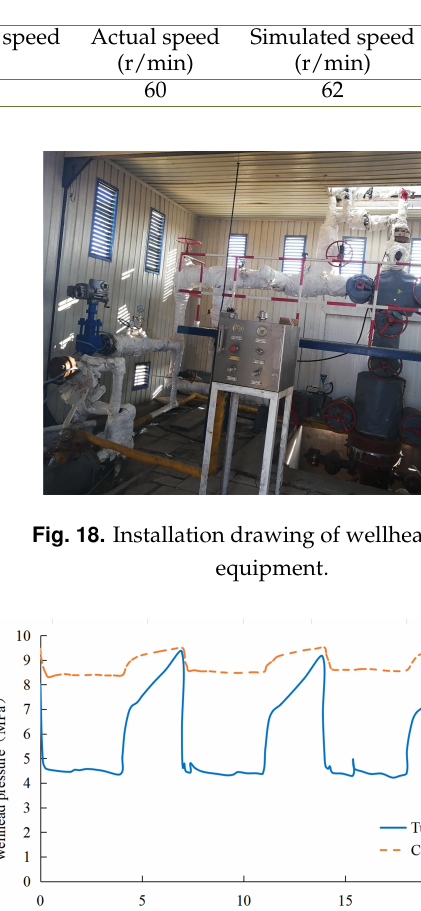
Table 6. Experiment on the effect of rotating plunger with 60 o .